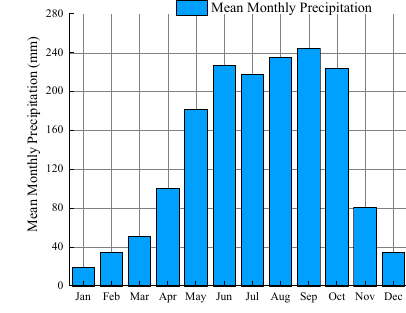
Figure 4. Climatic data in Haikou. Table 2. Design recommendations for each month of Haikou based on Mahoney table.